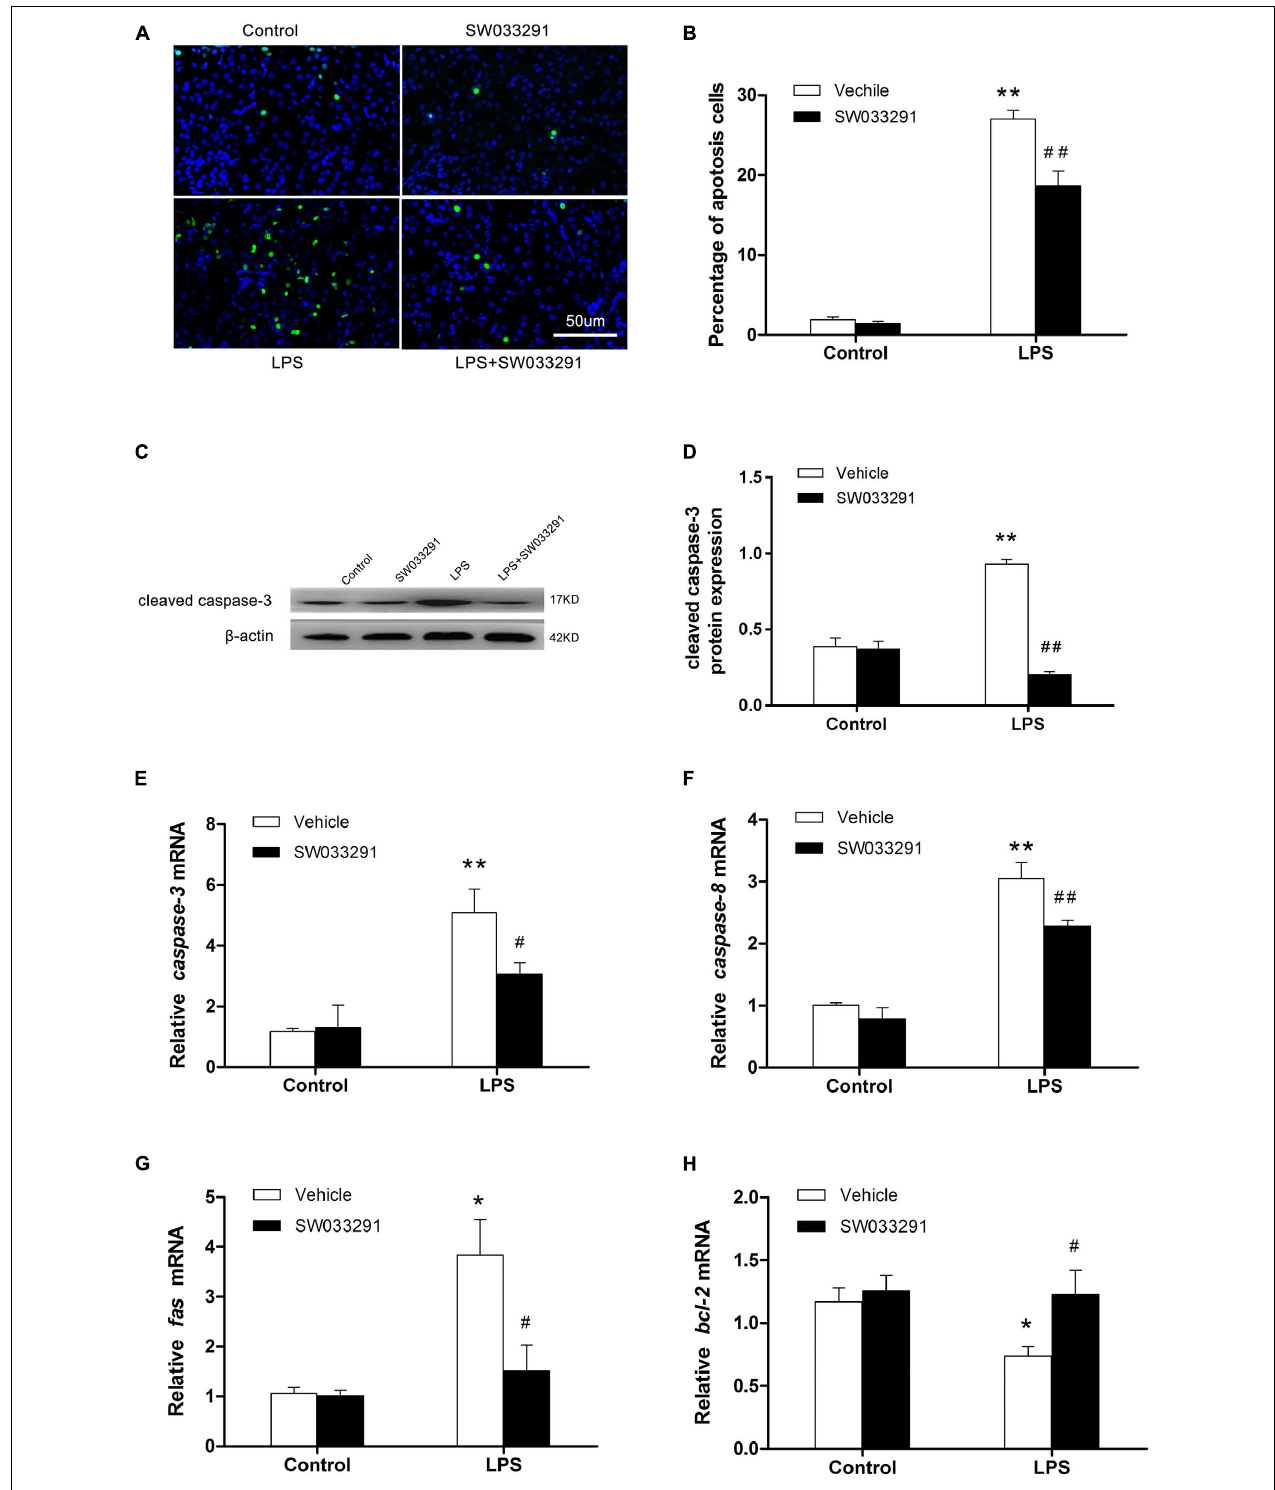
FIGURE 5 | SW033291 treatment alleviated the apoptosis of renal cells in LPS-induced AKI mice. (A) TUNEL staining shows the apoptotic renal cells after 12 h of SW033291 (10 mg/kg) treatment (400 × ). Scale bar: 50 µ m. (B) Percentage of apoptotic cells ( n = 6). (C) Western blot analysis of cleaved caspase-3 in each group after 12 h of SW033291 (10 mg/kg) treatment. (D) Density ratio of cleaved caspase-3/ β -actin in each group ( n = 3). (E–H) Real-time PCR was used to detect the apoptotic genes of caspase-3, caspase-8, Fas, and Bcl-2 ( n = 6). * P < 0.05, ** P < 0.01 vs. CON; # P < 0.05, ## P < 0.01 vs. LPS. Data are mean ± SD.